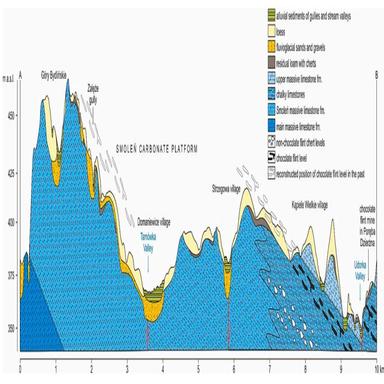
Schematic geological cross-section from Załęze ˙ gully to flint mine in Poręba Dzierzna ˙ (Udorka Valley) (based on, modified according to our field observations); cross-section line shown in.